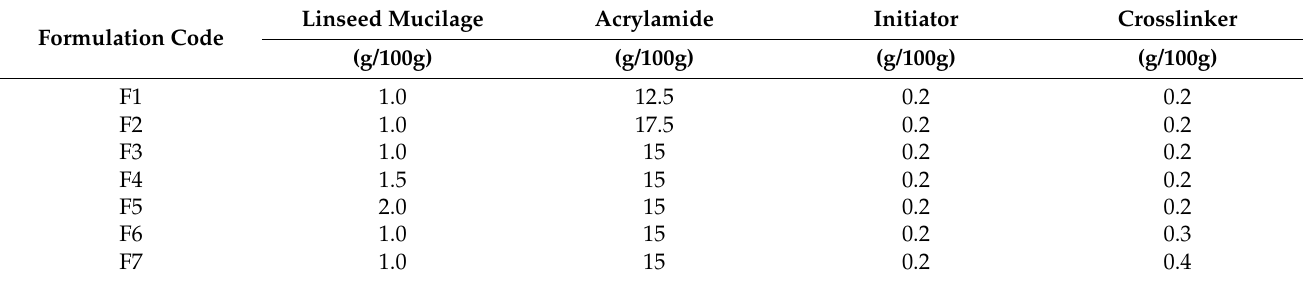
Table 4. Composition of numerous formulations of linseed-co-AAM graft copolymer. Formulation